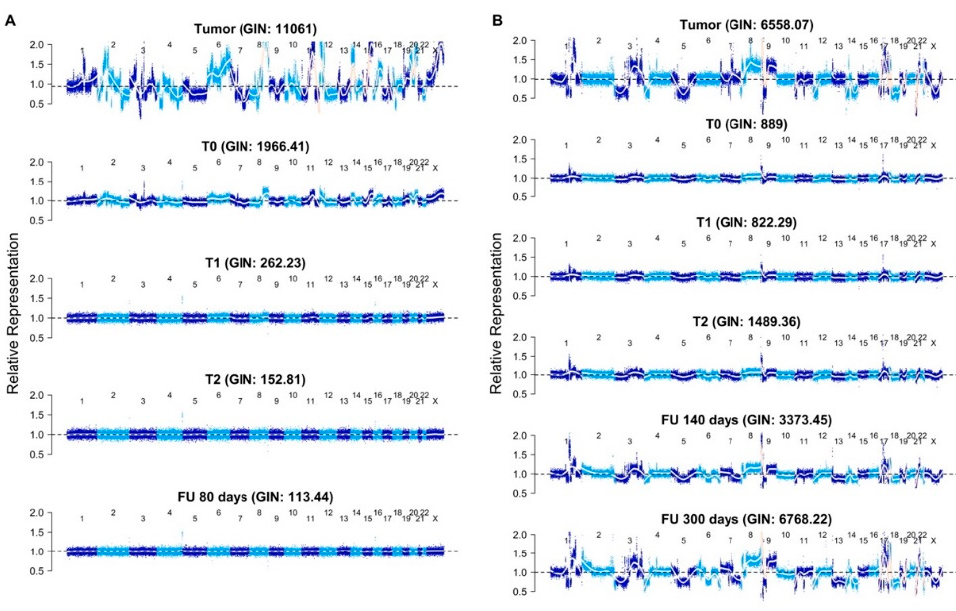
Figure 1. Genome-wide representation of the profile obtained from low-pass whole-genome sequenc- ing of the tumor DNA (top sample) and serial plasma samples (T0 (prior to treatment), one week (T1), two weeks (T2)—as defined in the text—and a follow-up (FU)) plasma sample obtained 80, 140 or 300 days after treatment initiation. The Genomic Instability Index (GIN) is indicated above each sample. The profiles show the Log2 DNA copy number values relative to the diploid 1.0 value for each chromosome from 1 to X, left to right. ( A ) Patient showing a response to treatment. ( B ) Patient showing a progressive disease. Note that the profile in the plasma at 300 days is very similar to the tumor’s DNA copy number profile in the nonresponding patient, whereas the plasma genomic profile progressively flattens out after treatment initiation in the responding patient.